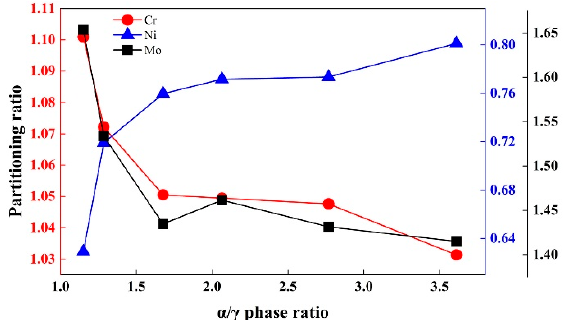
Figure 6. The elements partitioning ratio varies with the α / γ ratio.